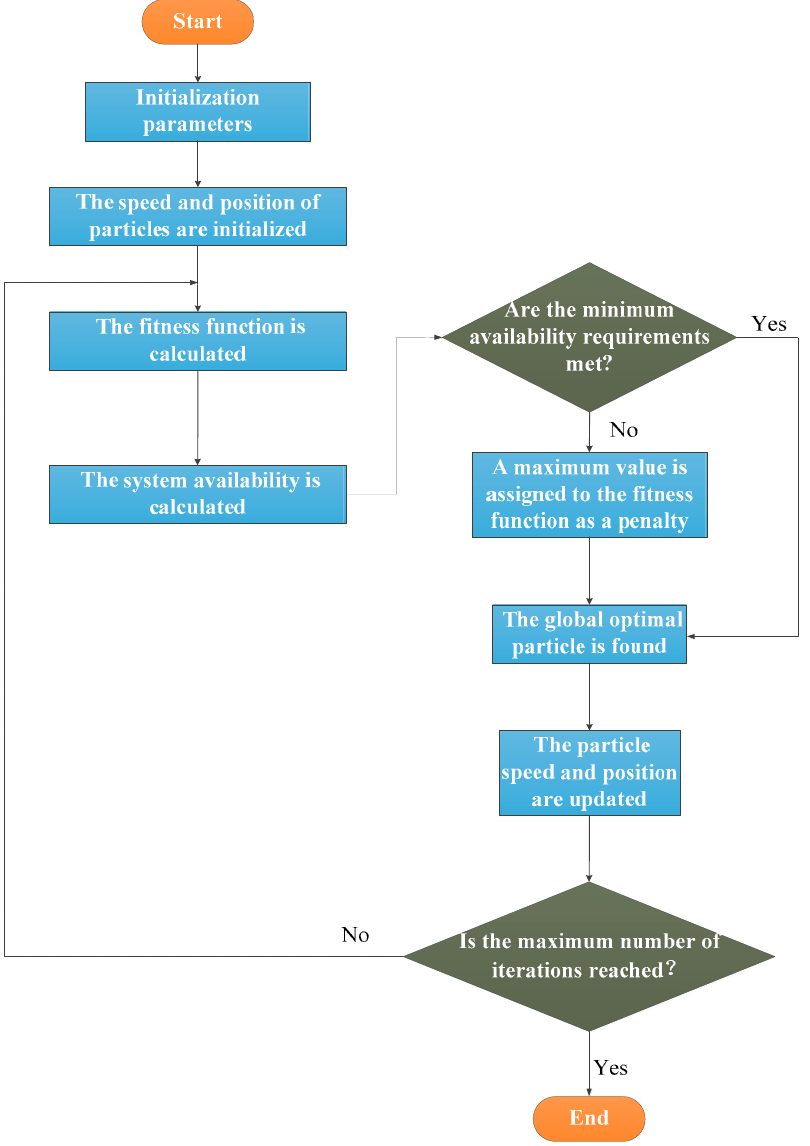
Figure 8. The flow chart for applying the PSO–BAS algorithm. The fundamental algorithmic procedure is presented in Table